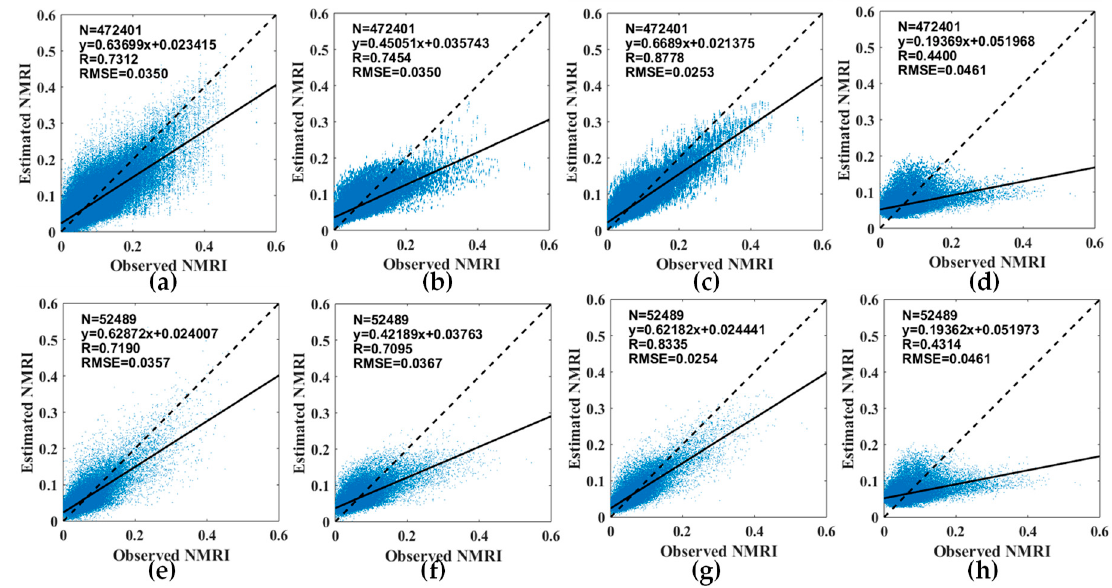
Figure 7. Scatter plots of the comparison model results: ( a ) BPNN-model fitting; ( b ) GRNN-model fitting; ( c ) RF-model fitting; ( d ) MLR-model fitting; ( e ) BPNN-cross-validation; ( f ) GRNN-cross-validation; ( g ) RF-cross-validation; ( h ) MLR-cross-validation. The dashed line is the 1:1 line . Footnote: BPNN (Back-Propagation Neural Network), GRNN (Generalized Regression Neural Network), RF (Random Forest), MLR (Multiple Linear Regression)